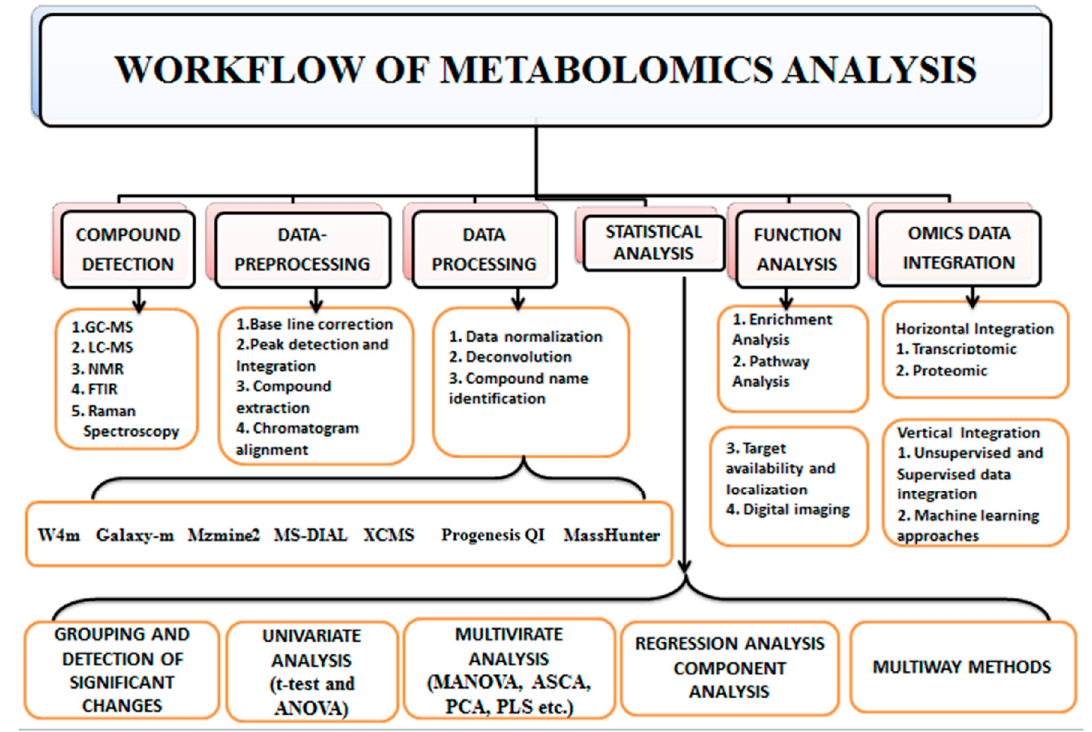
Figure 3. Workflow of Metabolomics. The first step of the metabolomics workflow is compound detection; by employing mass spectrometry, NMR, FTIR, etc. The second step is data